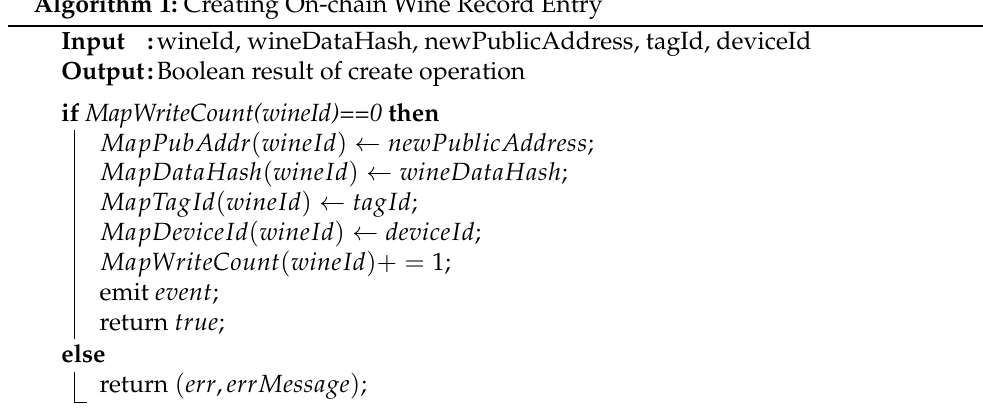
Algorithm 1: Creating On-chain Wine Record